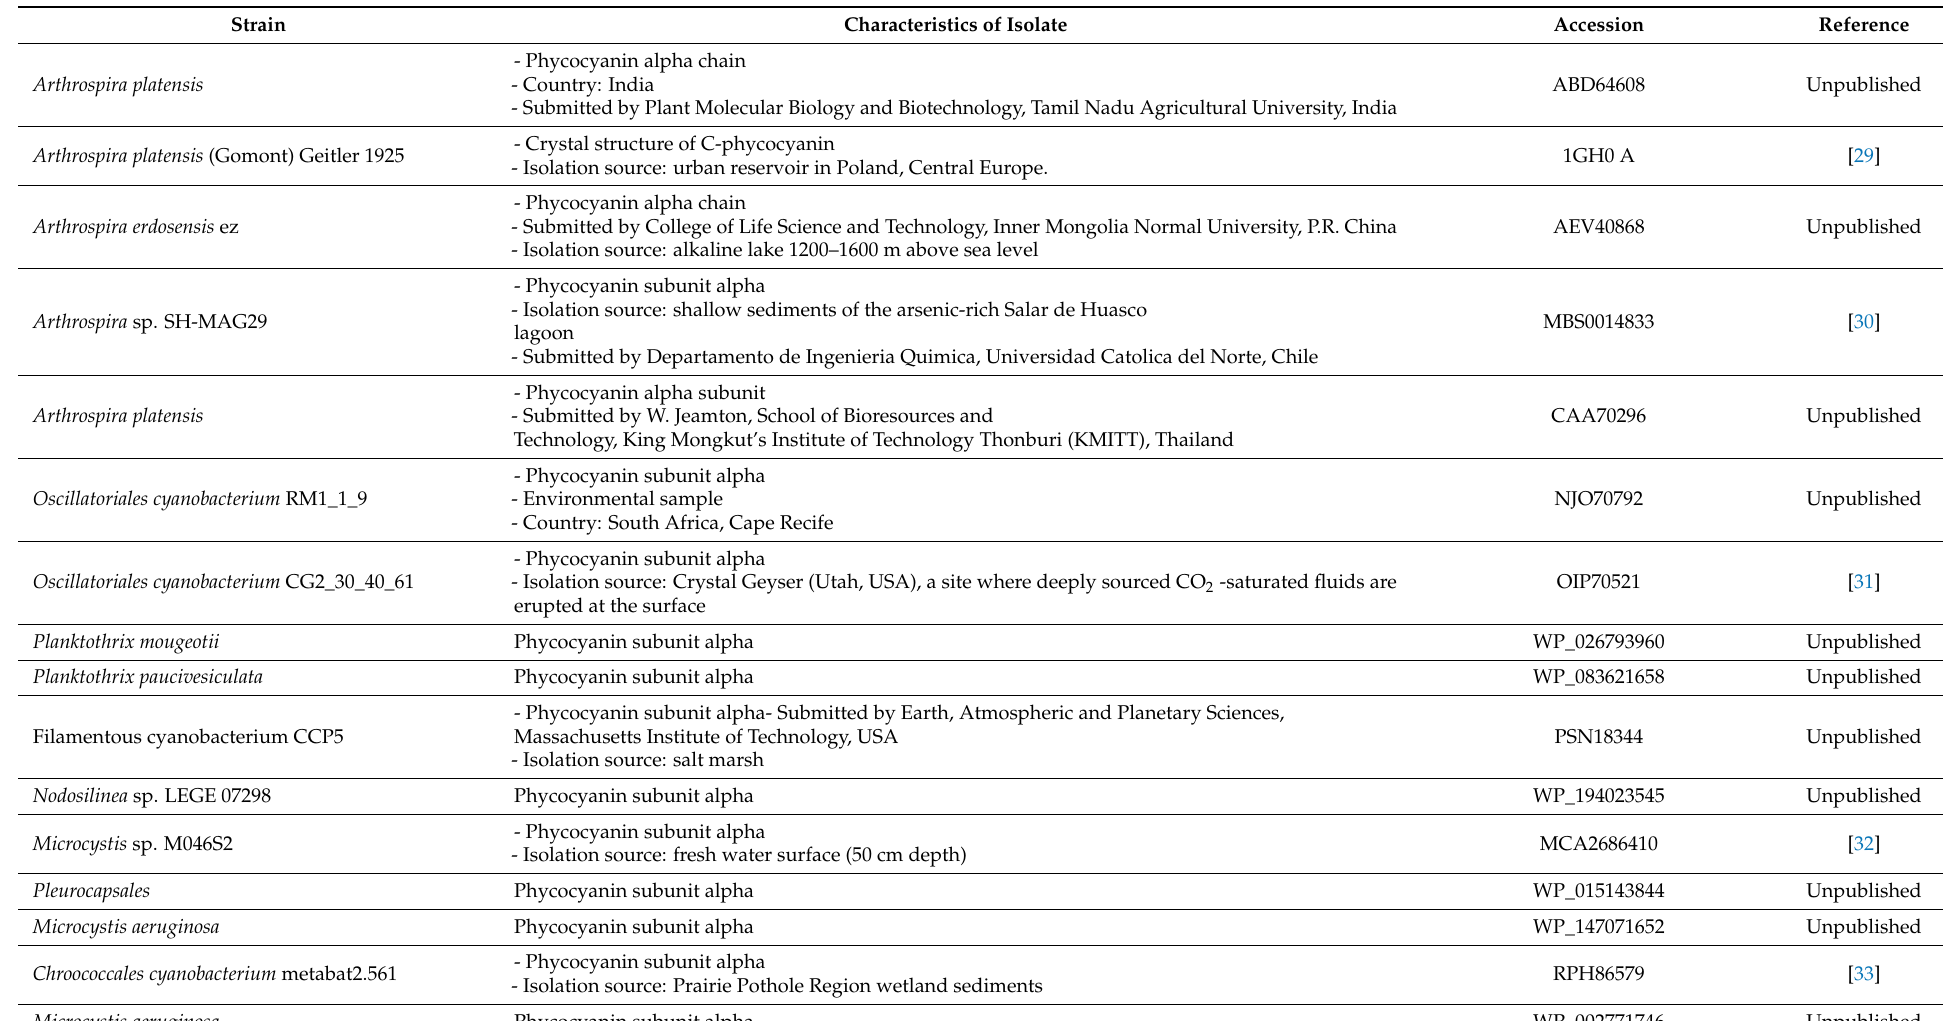
Table 6. Characteristics of the investigated cyanobacterial organisms and source of